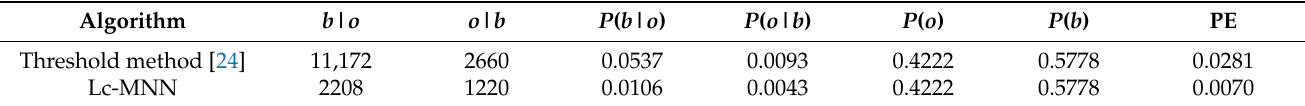
Table 1. Lc-MNN segmentation algorithm and threshold segmentation algorithm PE